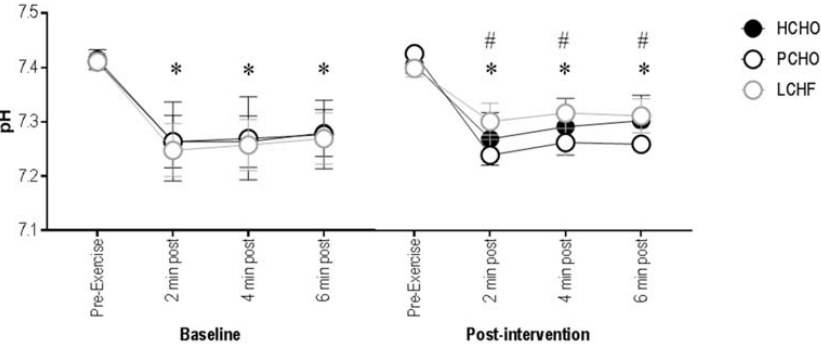
Figure 2. Blood pH for the high carbohydrate (HCHO), periodized carbohydrate (PCHO), and low carbohydrate high fat (LCHF) groups for baseline and post ‐ intervention, at pre ‐ exercise, plus 2, 4, and 6 min post ‐ test. * Significantly different to pre ‐ exercise ( p < 0.05). # PCHO significantly different to LCHF ( p < 0.05).